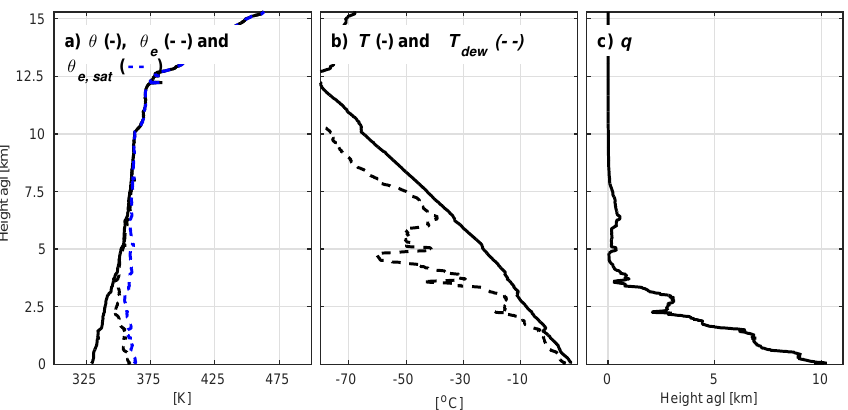
Figure 2. Initial profile for Nam Co Lake 17 July 2012 06:00LT used in the model simulations as measured by radiosonde. (a) Potential ( θ ), equivalent potential temperature ( θ e ), and saturated equivalent potential temperature ( θ e,sat ); (b) temperature ( T ) and dew-point temperature ( T dew ) and (c) mixing ratio ( q